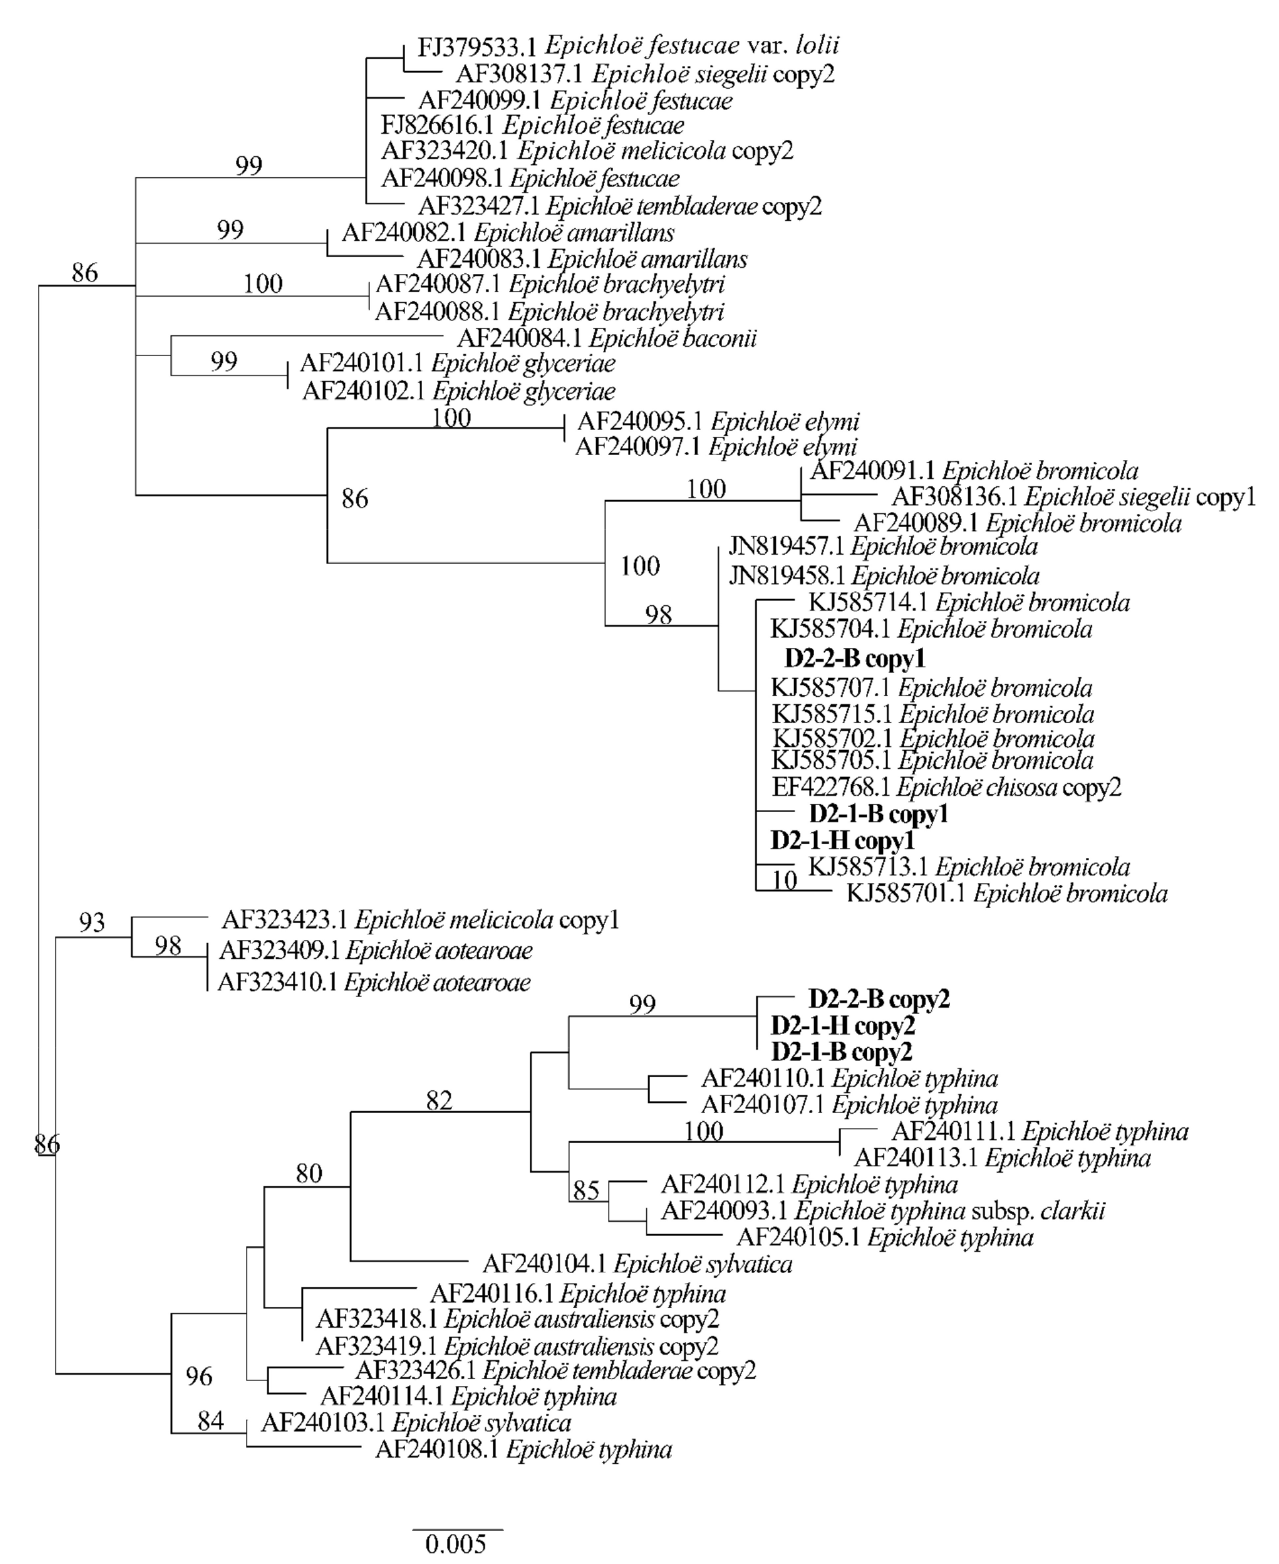
Figure 4. Molecular phylogeny derived from maximum likelihood (substitution model TIM2e + G4) analysis of the actG gene from representative Epichloë species and copies of the hybridized endophytes isolated from H. bogdanii